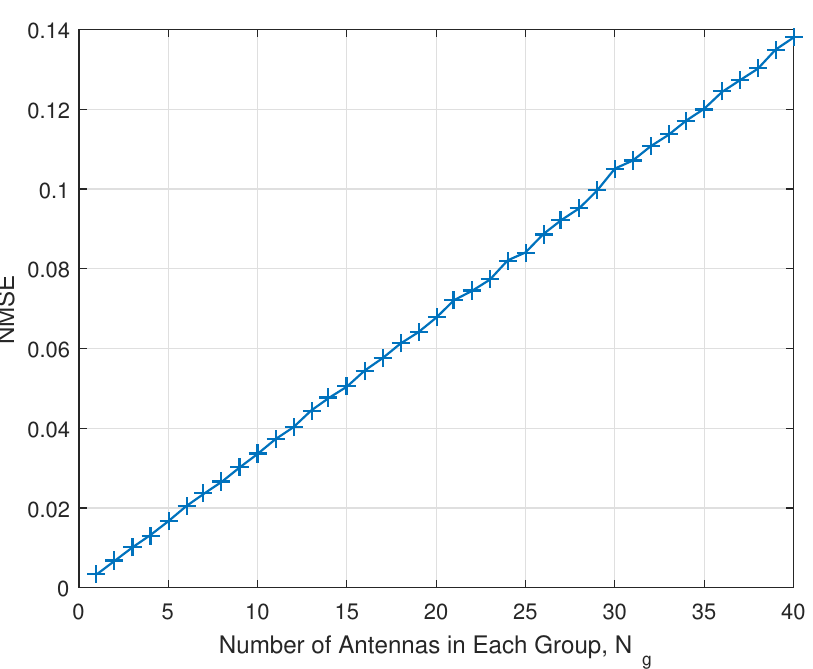
Figure 5. Seriousness of channel estimation error: normalized mean square error (NMSE) versus N g